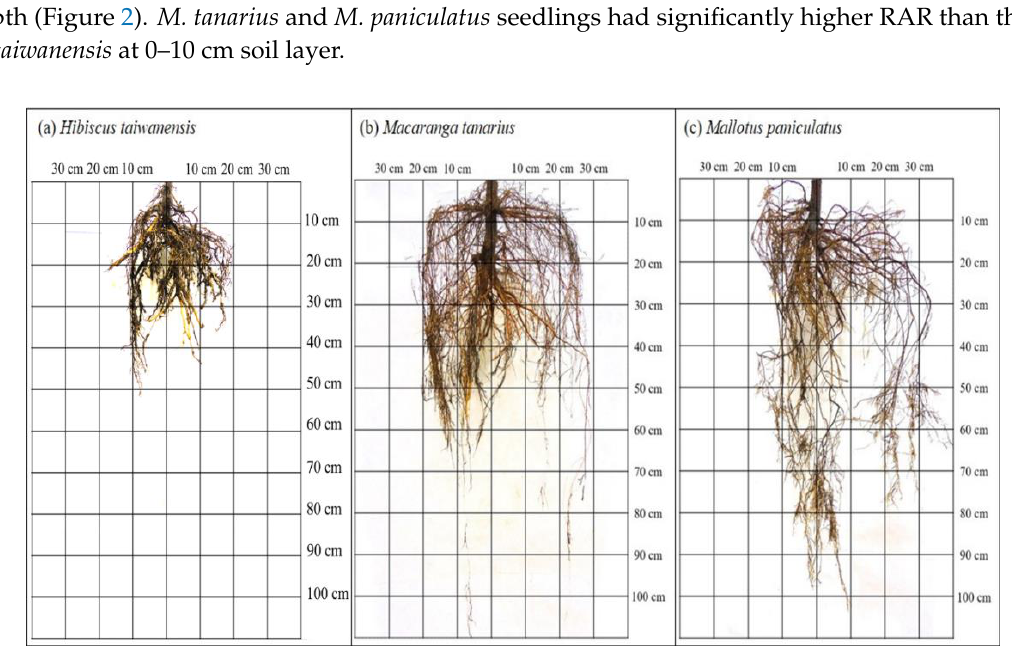
Figure 1. Typical root system architecture of 1-year-old Hibiscus taiwanensis ( a ) , Macaranga tanarius ( b ) and Mallotus paniculatus ( c )